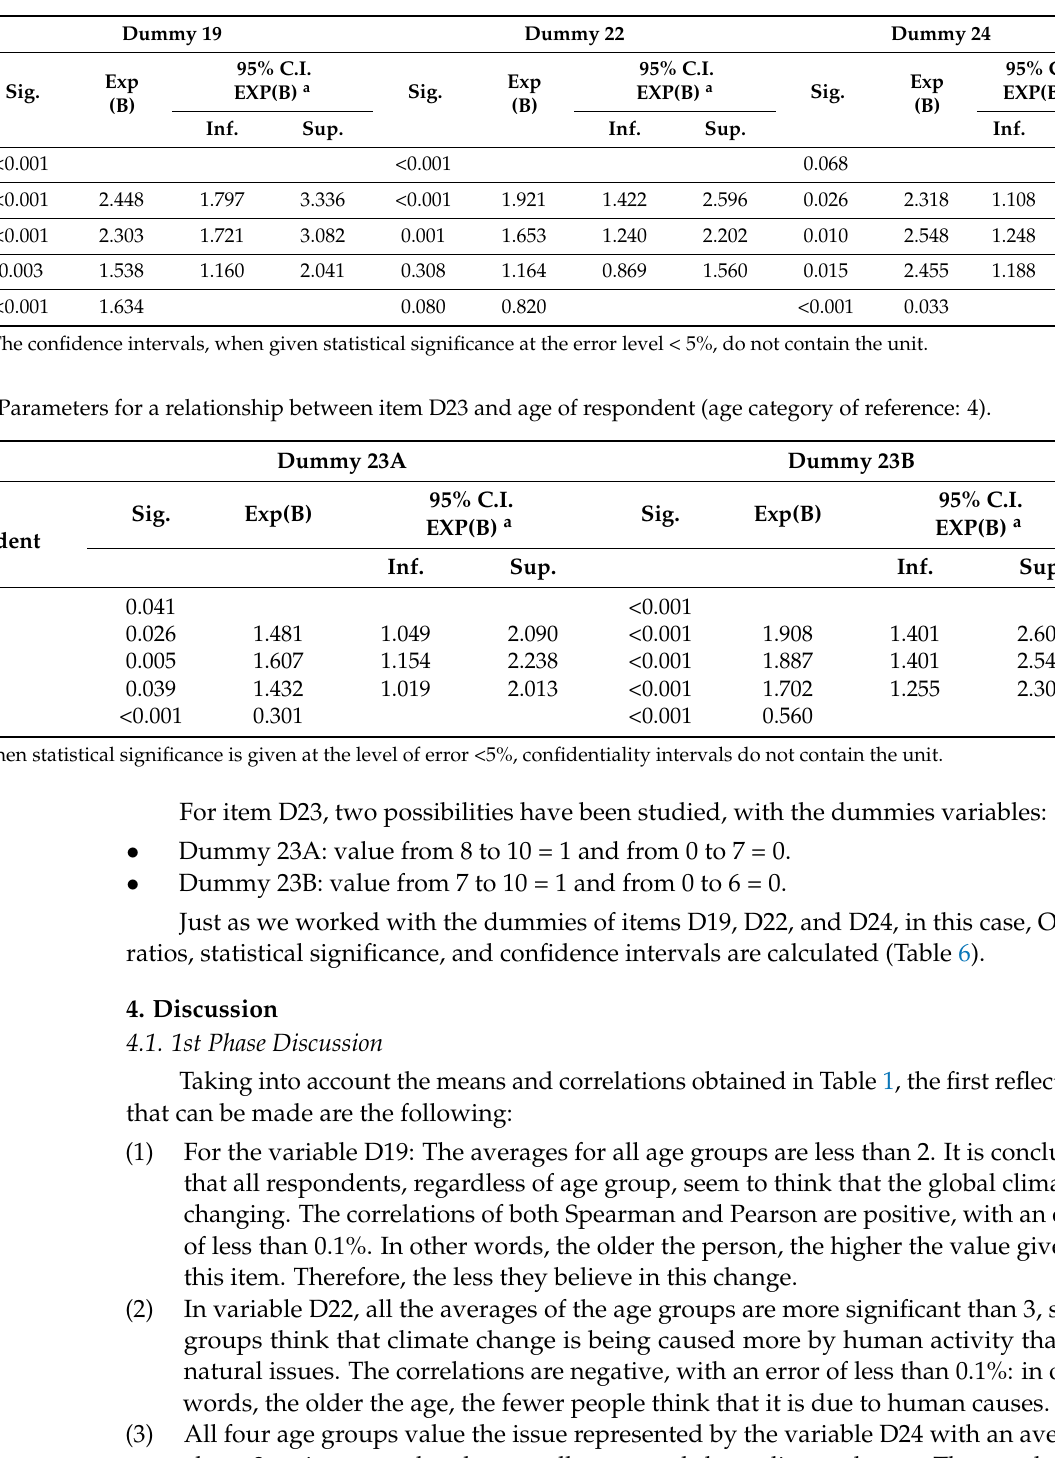
Table 5. Parameters for the relationship between items and age of respondent (age category of reference: 4).